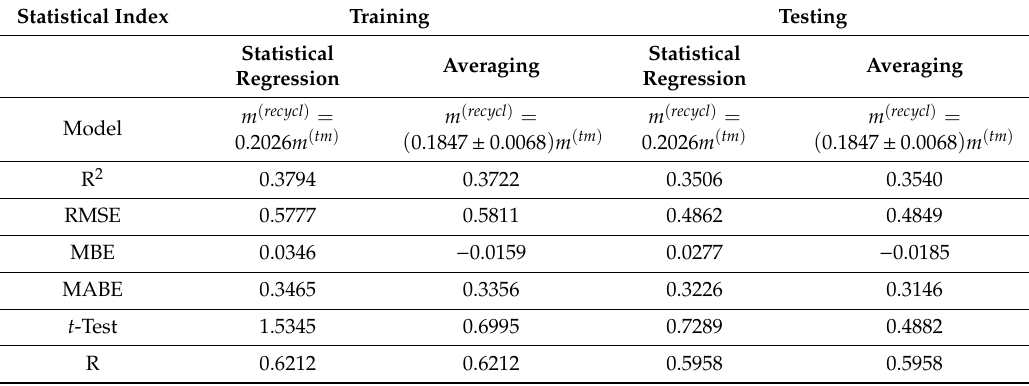
Table 4. The statistical indices of the regression and averaged models of recyclable MSW